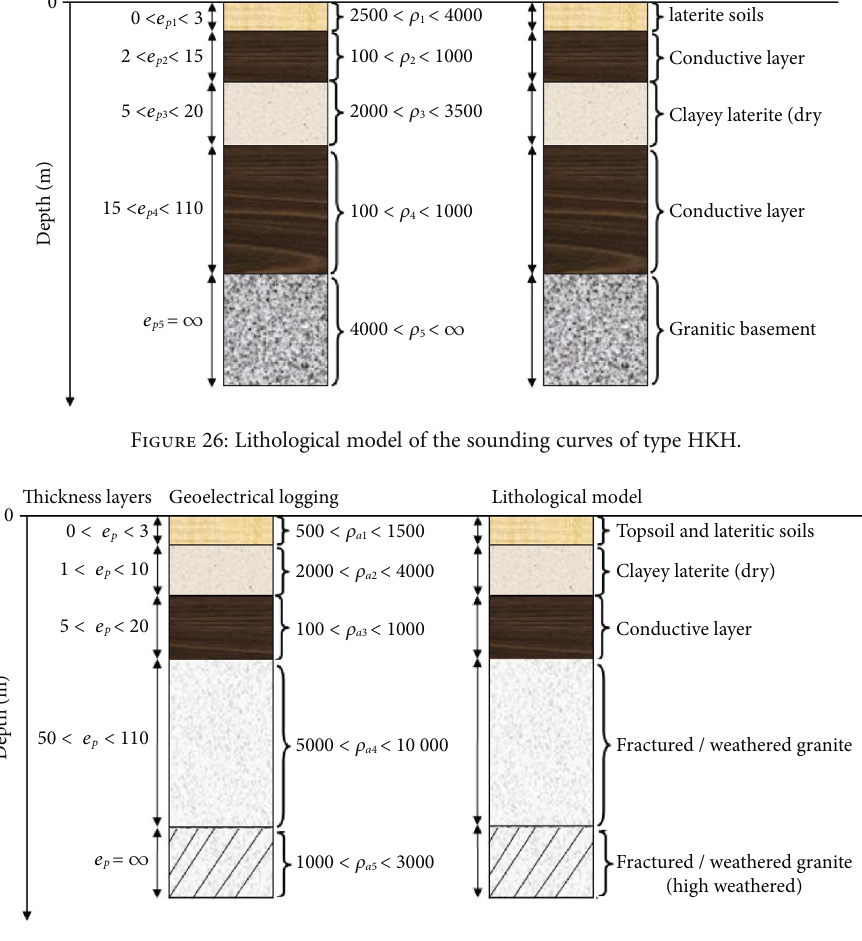
Figure 27: Lithological model of the sounding curves of type